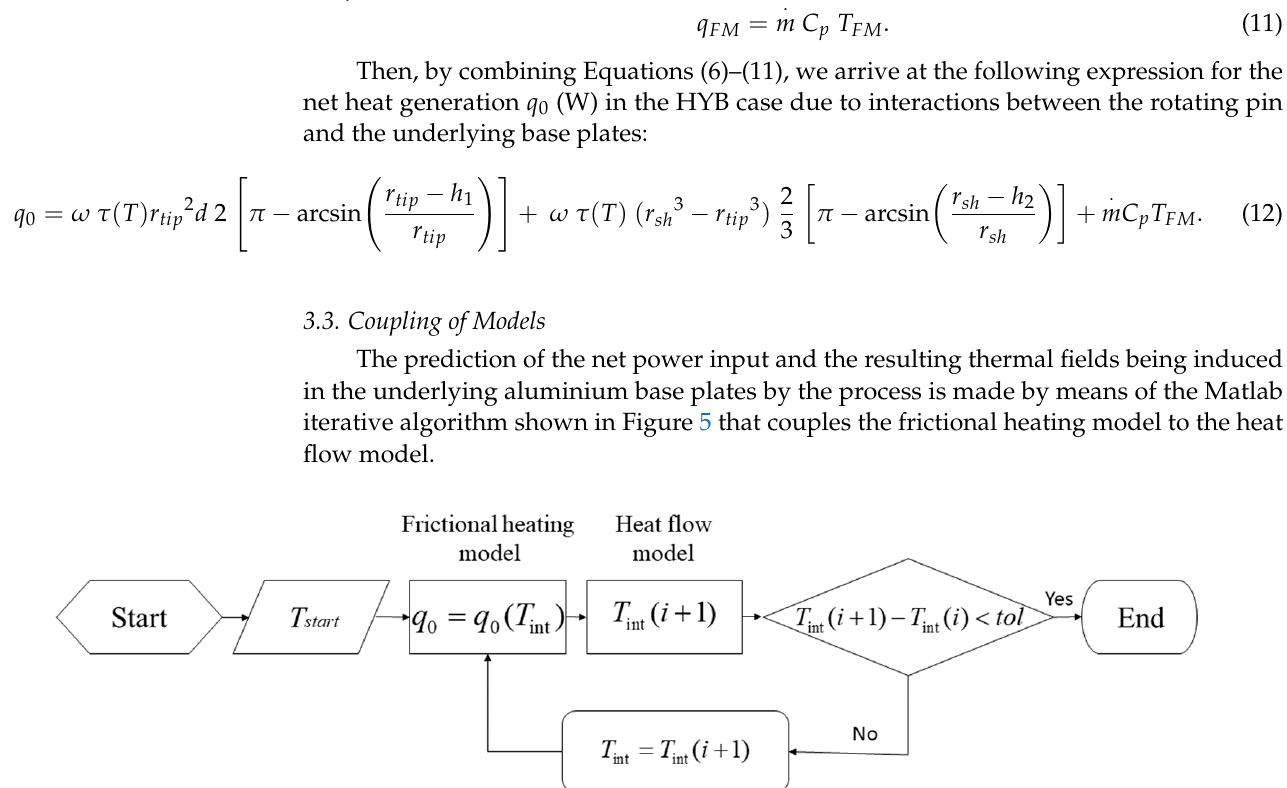
Table 1 summarises the input data used in the